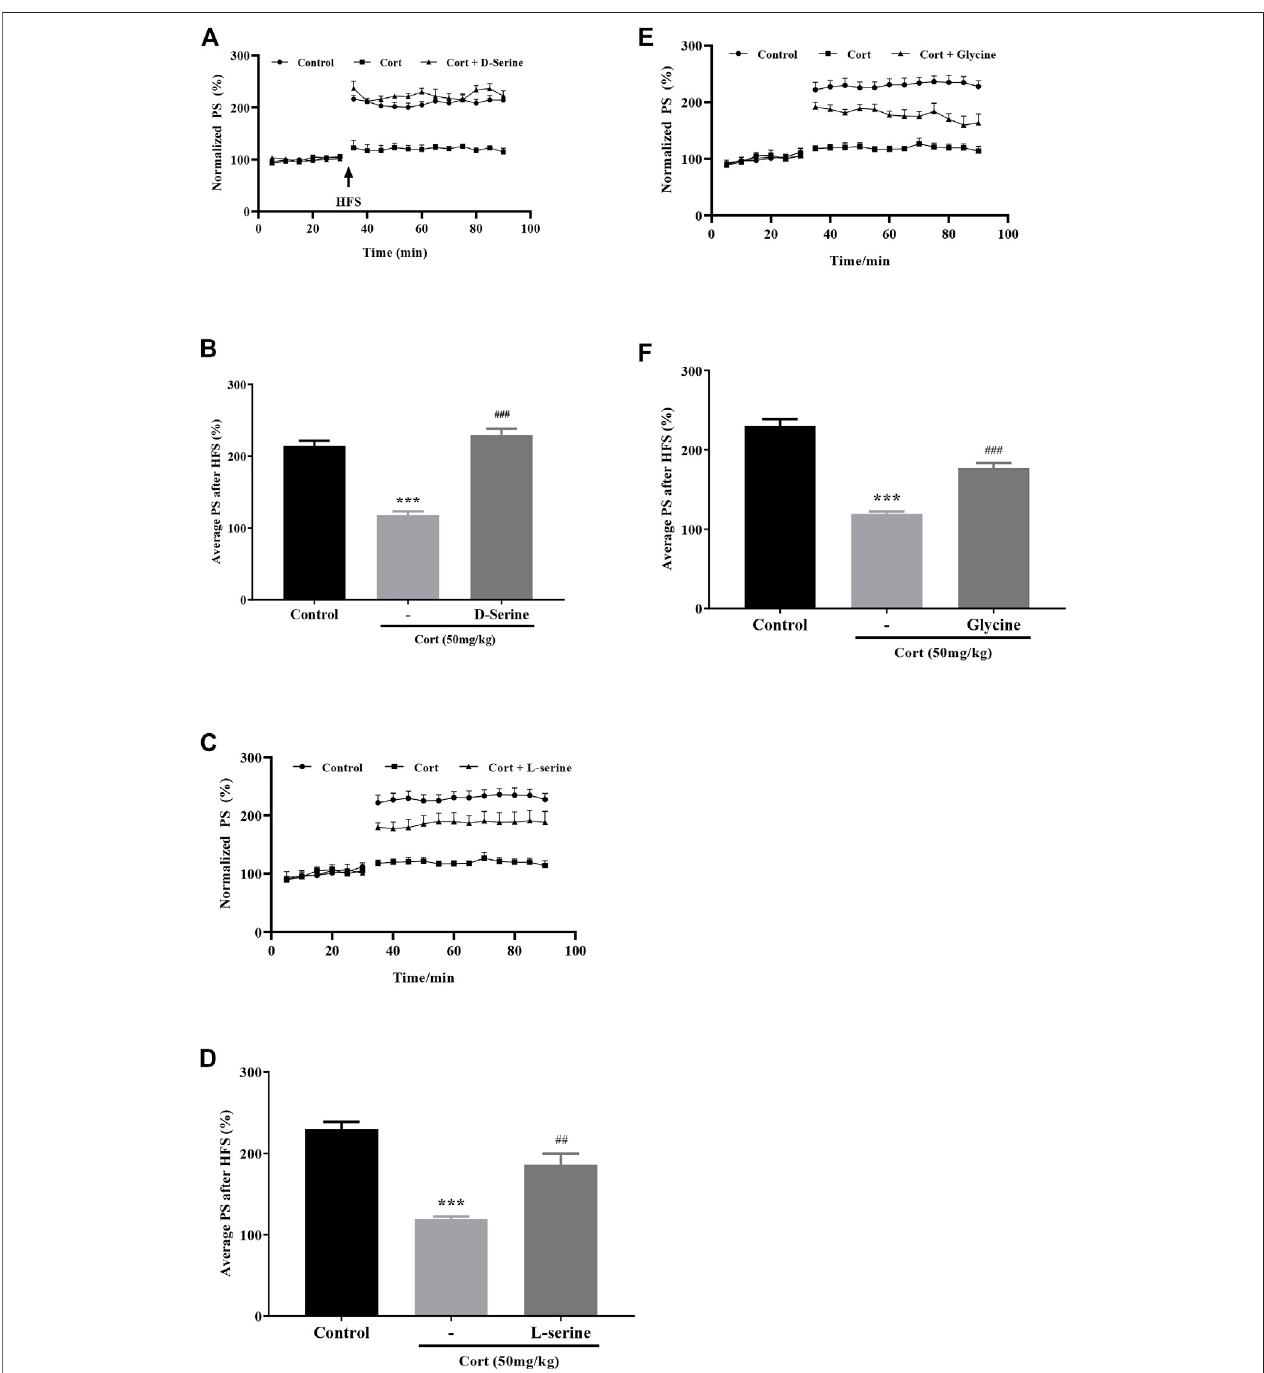
FIGURE 4 | Effects of D-serine, L -serine, and glycine on LTP impairment by corticosterone (Cort). (A) Time course of average relative PS amplitudes. (B) Average relative PS amplitudes after HFS; Cort/vehicle was injected 60 min before HFS, and D -serine was administrated 30 min before Cort. (C) Time course of average relative PSamplitudes. (D) AveragerelativePSamplitudesafterHFS;Cort/vehiclewasinjected60 minbeforeHFS,and L -serinewasadministrated30 minbeforeCort. (E) Time course of average relative PS amplitudes. (F) Average relative PS amplitudes after HFS; Cort/vehicle was injected 60 min before HFS, and glycine was administrated 30 min before Cort. Data are shown as the mean ± SEM, n = 4 – 7. *** p < 0.001 compared to the Control group; ## p < 0.01, ### p < 0.001 compared to the Cort group.